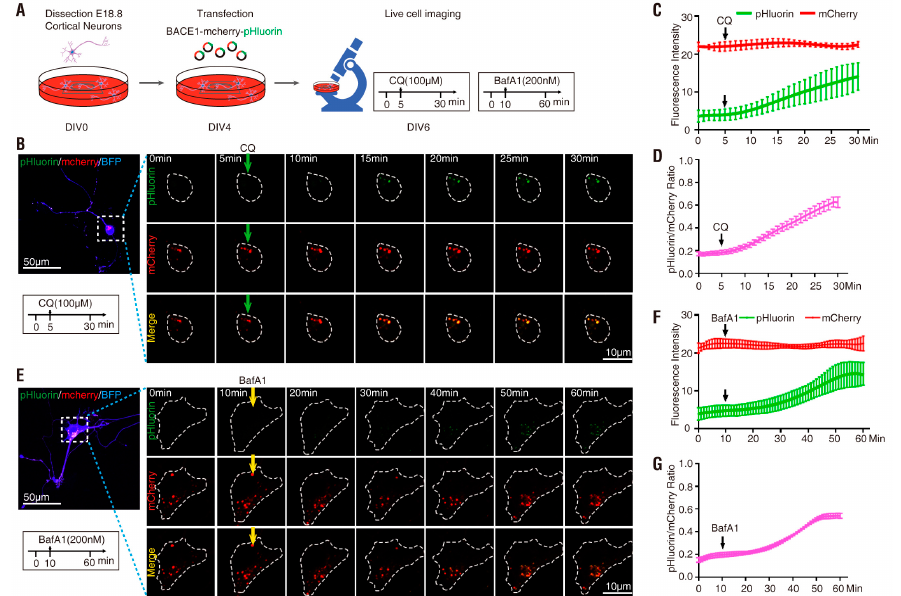
Figure 5. Response of primary cortical neurons expressing BACE1-mCherry-pHluorin to CQ and BafA1 treatment ( A ) Schematics of live cell imaging experimental procedures. Cortical neurons were dissected from E18.5 mice and plated on 35 mm glass-bottom culture dishes at DIV0. Neurons were co-transfected with BACE1-mCherry-pHluorin and BFP at DIV4 and imaged every minute for 30 min at DIV6 and treated with 100 µ M CQ after 5 min or imaged every minute for 60 min at DIV6 and treated with 200 nM BafA1 after 10 min. ( B ) Representative images from live cell imaging in response to CQ. The soma expressing BACE1-mCherry-pHluorin (red and green) were outlined according to BFP expression. Scale bar, 10 µ m or 50 µ m. ( C ) The fluorescence signal intensity of mCherry (red) and pHluorin (green) in the outlined area was measured using ImageJ and plotted over time in response to CQ. Data were shown as mean ± SEM ( n > 15 neurons from three independent experiments). ( D ) Quantification analysis of the pHluorin / mCherry ratio from C. Data was shown as mean ± SEM ( n > 15 neurons from three independent experiments). ( E ) Representative images from live cell imaging in response to BafA1. The soma expressing BACE1-mCherry-pHluorin (red and green) were outlined according to BFP expression. Scale bar, 10 µ m or 50 µ m. ( F ) The fluorescence signal intensity of mCherry (red) and pHluorin (green) in the outlined area was measured and plotted over time in response to BafA1. Data were shown as mean ± SEM ( n > 15 neurons from three independent experiments). ( G ) Quantification analysis of the pHluorin / mCherry ratio from F. Data was shown as mean ± SEM ( n > 15 neurons from three independent